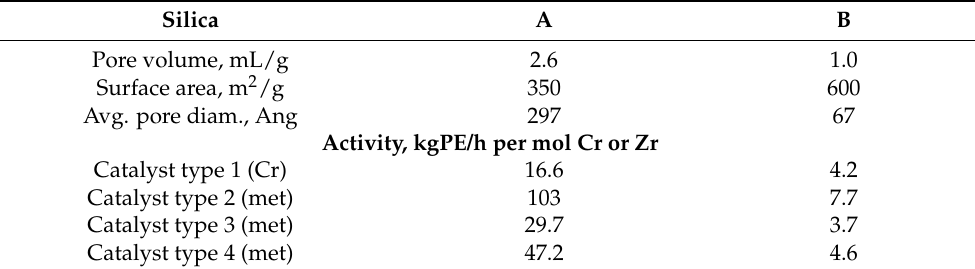
Table 2. Two silicas were used as a support in the preparation of Cr and three metallocene catalysts. In each case the less porous silica provided lower activity.